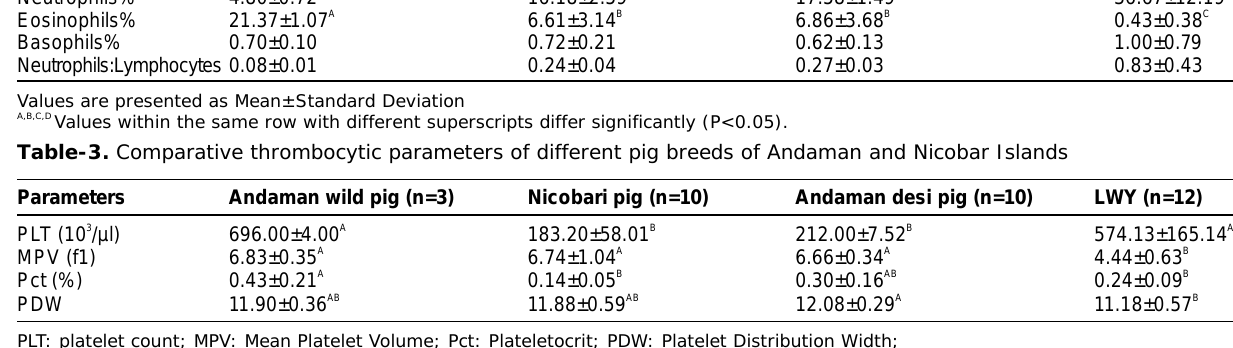
PLT: platelet count; MPV: Mean Platelet Volume; Pct: Plateletocrit; PDW: Platelet Distribution Width; Values are presented as Mean±Standard